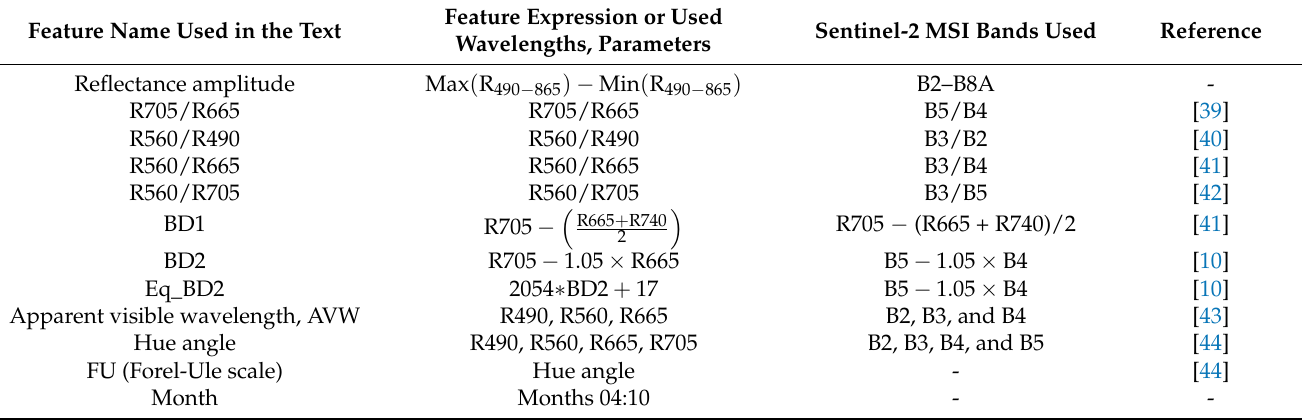
Table 3. Features used in machine learning algorithms to predict a biophysical class of a lake.